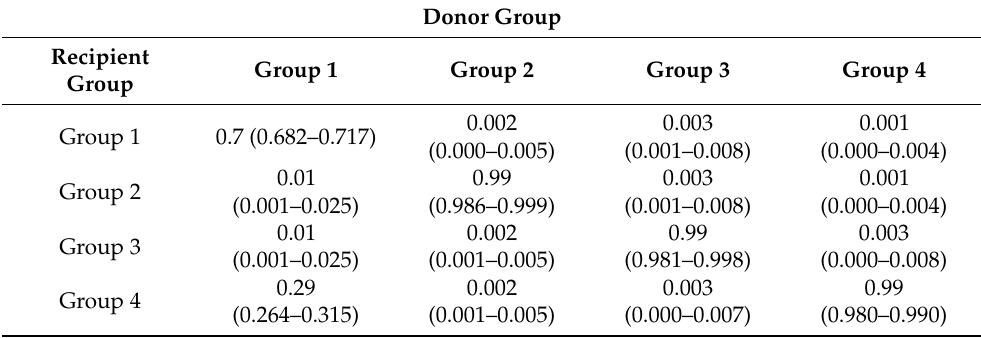
Table 5. Estimates of contemporary migration rates (95% confidence intervals) based on microsatellite data among groups of Natalus mexicanus . Group 1: Pe locality: Peninsula de Baja California; group 2: Pa, Ca, LV, Cr localities: Pacific and Gulf of Mexico; group 3: VB and SS localities: Pacific and San Sebastian; and group 4: Co, TG, Bo, and Cva localities: Pacific, Gulf of Mexico and Yucatan